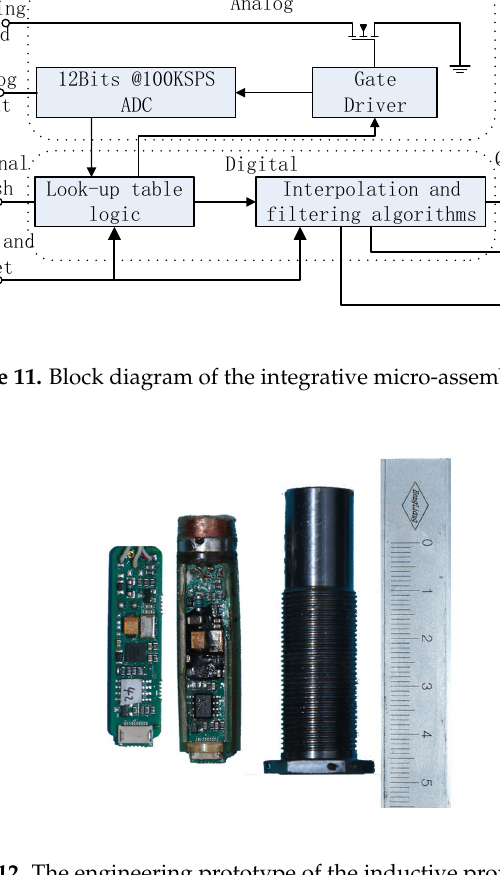
Figure 12. The engineering prototype of the inductive proximity